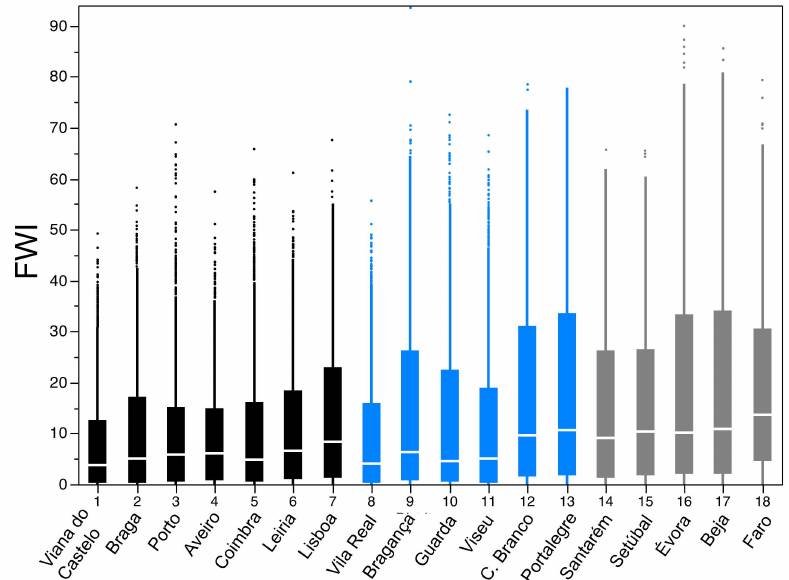
Figure 2. Boxplots (with outliers) of the fire weather index (FWI) daily variation for the regions ( distritos ) of Portugal (2001–2011). The box spans the interquartile range and the whiskers extend to the 90th and 10th percentiles. Black, blue, and grey boxplots correspond respectively to the NCW, NCE and S supra